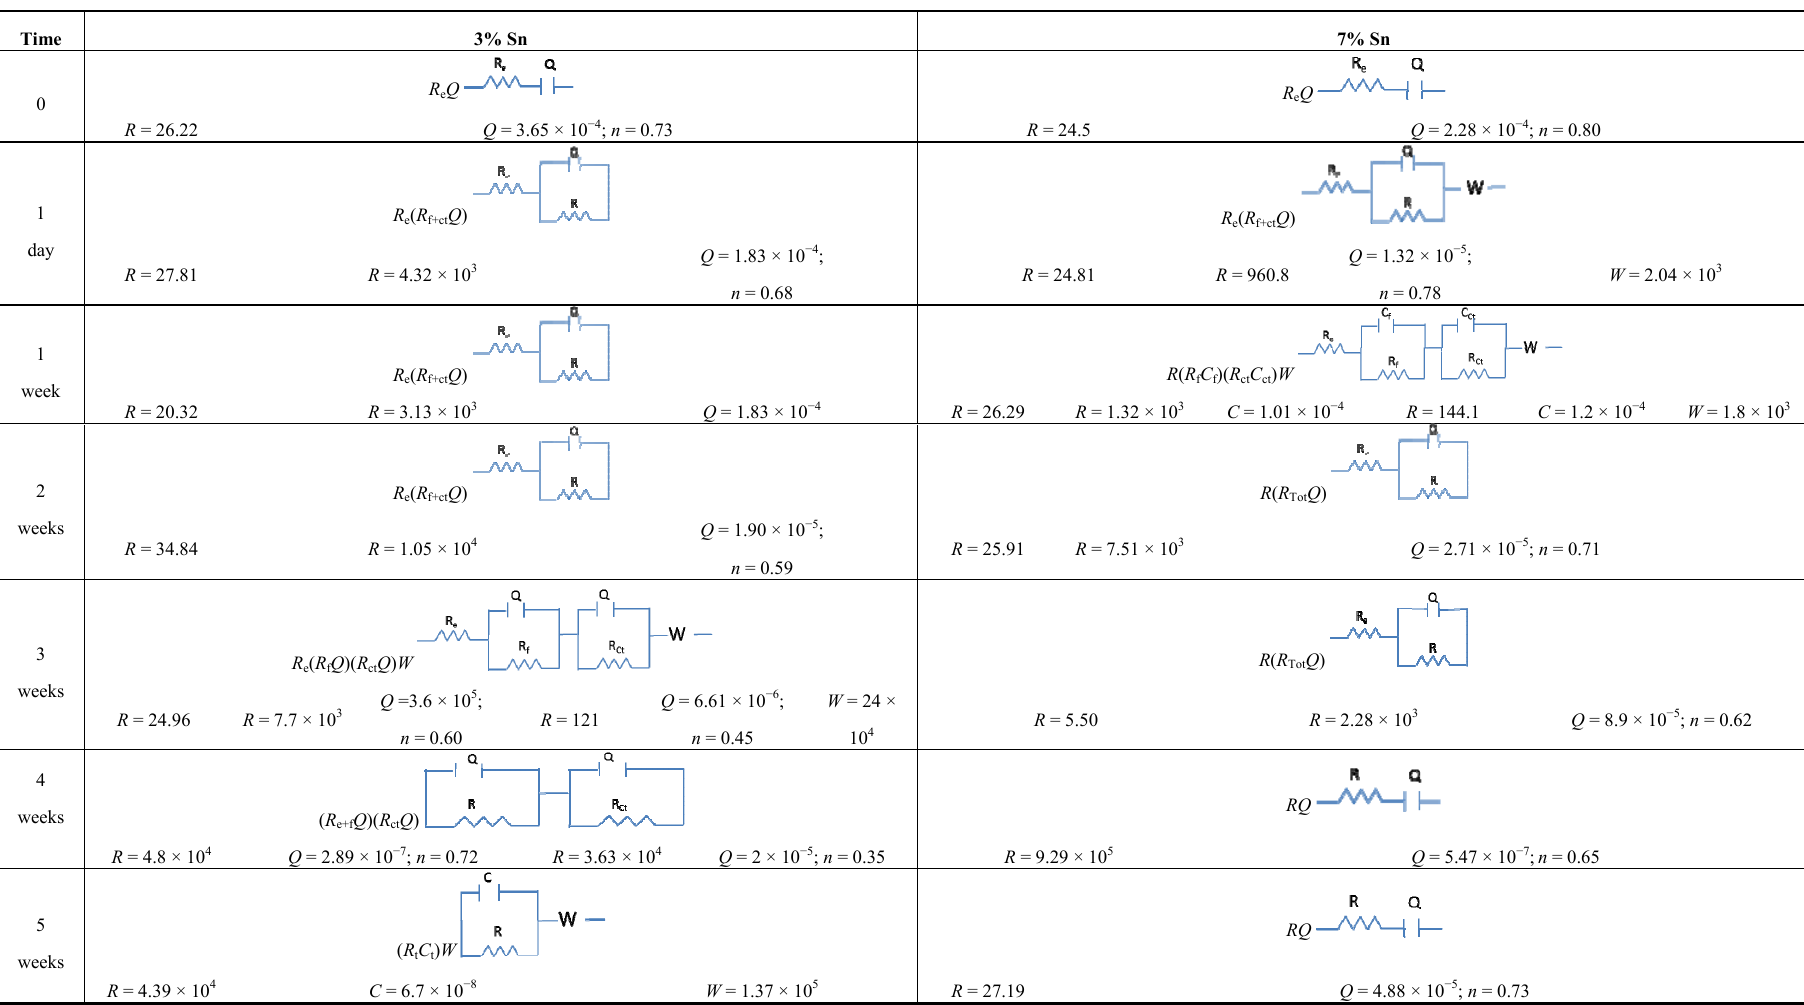
); the film f ); the Warburg ( W ); the constant e